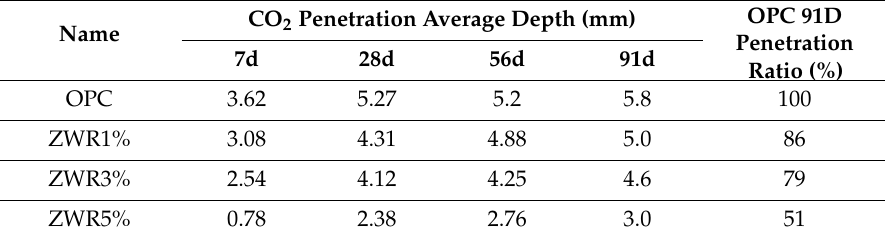
Table 12. Result of accelerated carbonation test.